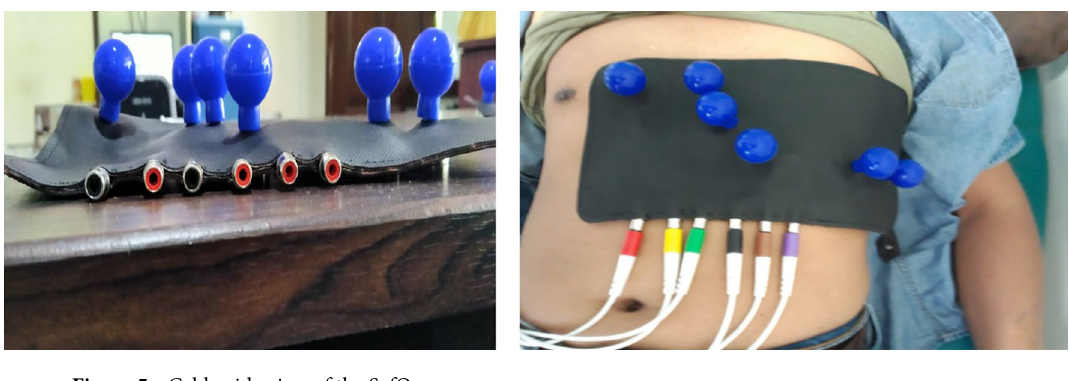
Figure 5. Cable-side view of the